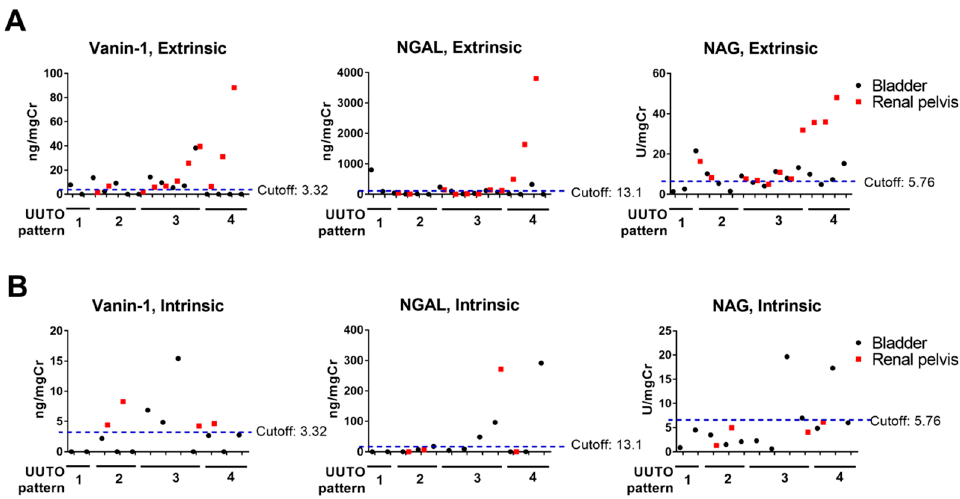
Figure 4. The levels of AKI biomarkers in the bladder and renal pelvic urine according to the UUTO pattern. The levels of vanin-1, NGAL, and NAG in the bladder and renal pelvic urine according to the UUTO pattern in extrinsic ( A ) and intrinsic UUTO ( B ) are shown. Black and red dots indicate the values in bladder urine and renal pelvic urine, respectively. Cut-off for each biomarker in RP urine (blue dashed line) was also shown.